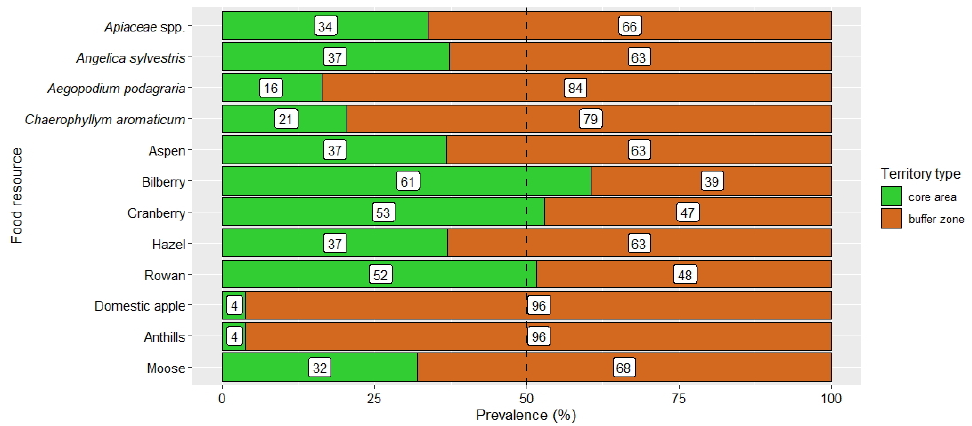
Figure 6. Prevalence (predicted presence area in %, corrected by size of territory type) for the main brown bear food resources in the Central Forest State Nature Reserve core and its buffer zone (West-European Russia) in 2008–2020. Black dotted line indicates equal area (50%) for both area types. Labels indicate prevalence in% for each food resource by area type.